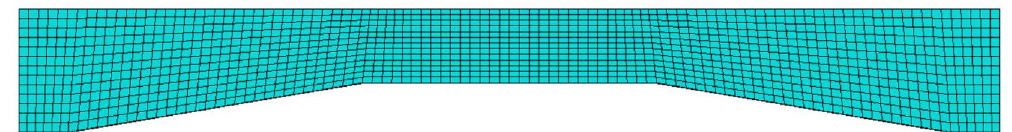
Figure 4. Details of the meshed model.